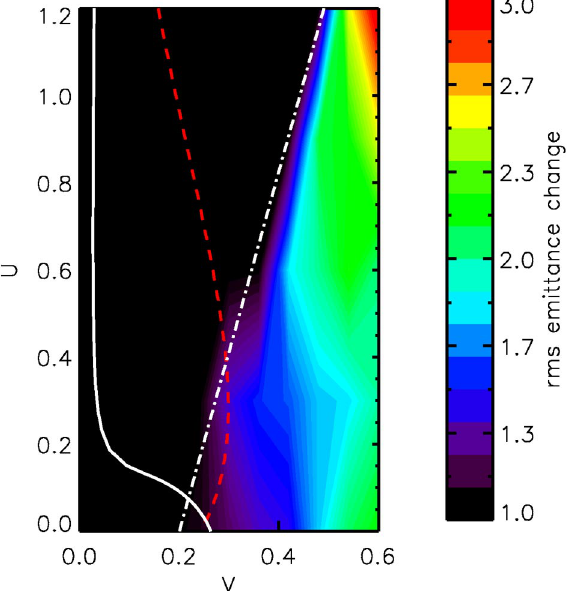
FIG. 6. (Color) Emittance increase in a sausage beam as a function of initial (cid:1) U; V (cid:5) values with n corresponds to a stable beam. .